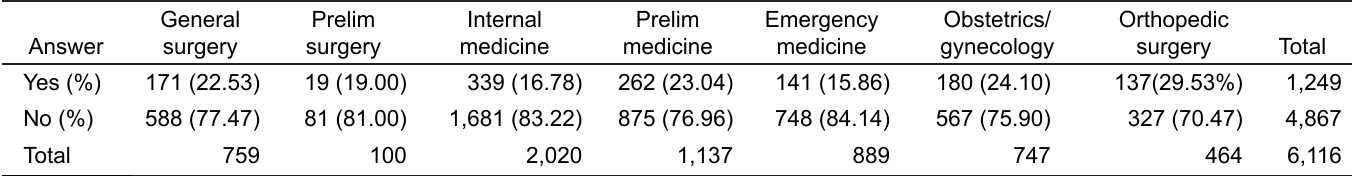
Table 1. Specialty distribution of commitment questions (N=912).